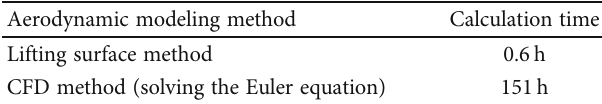
Table 2: Comparison of the calculation